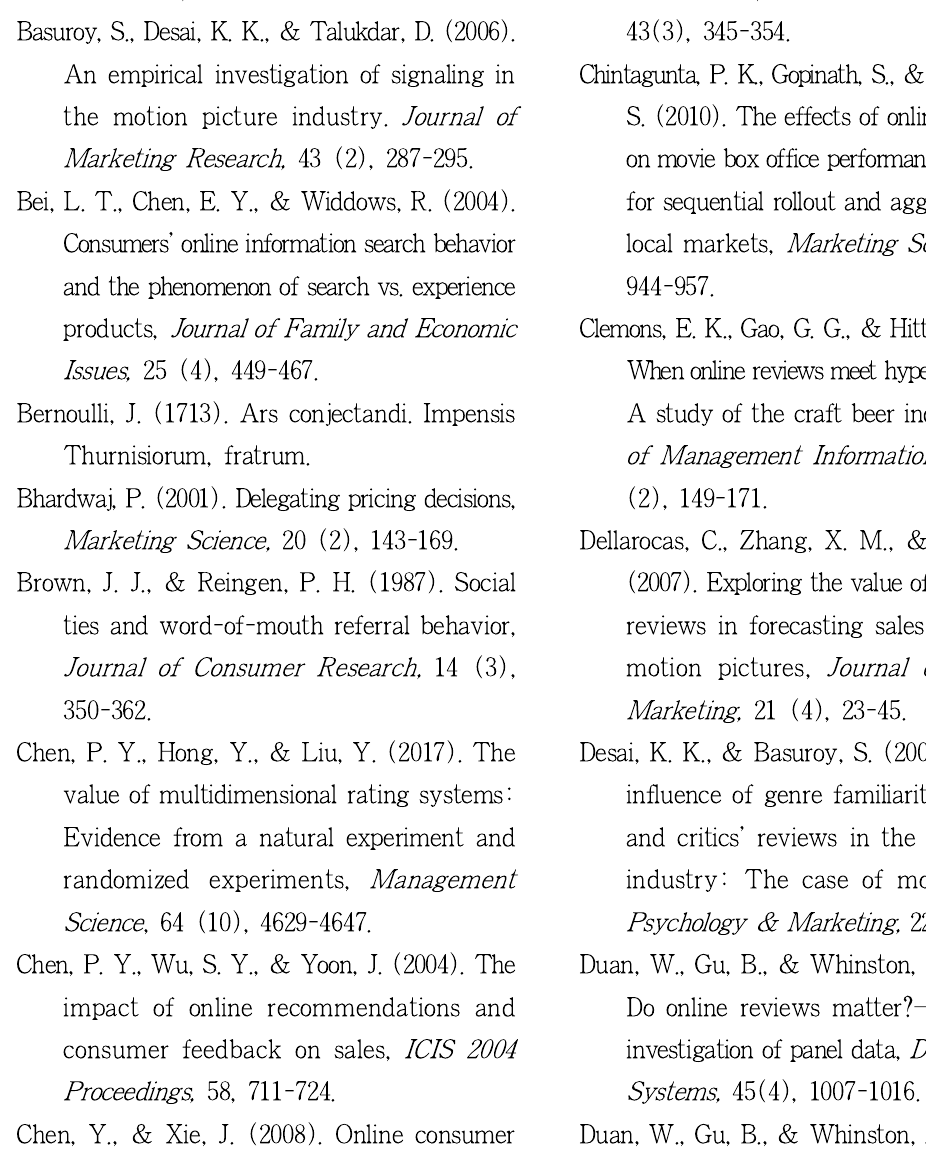
The Effect of Rating Dispersion on Purchase of Experience Goods based on the Korean Movie Box Office Data